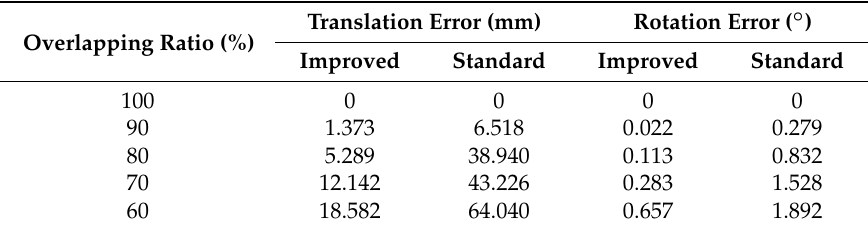
Table 3. Deviation in the translation and rotation.